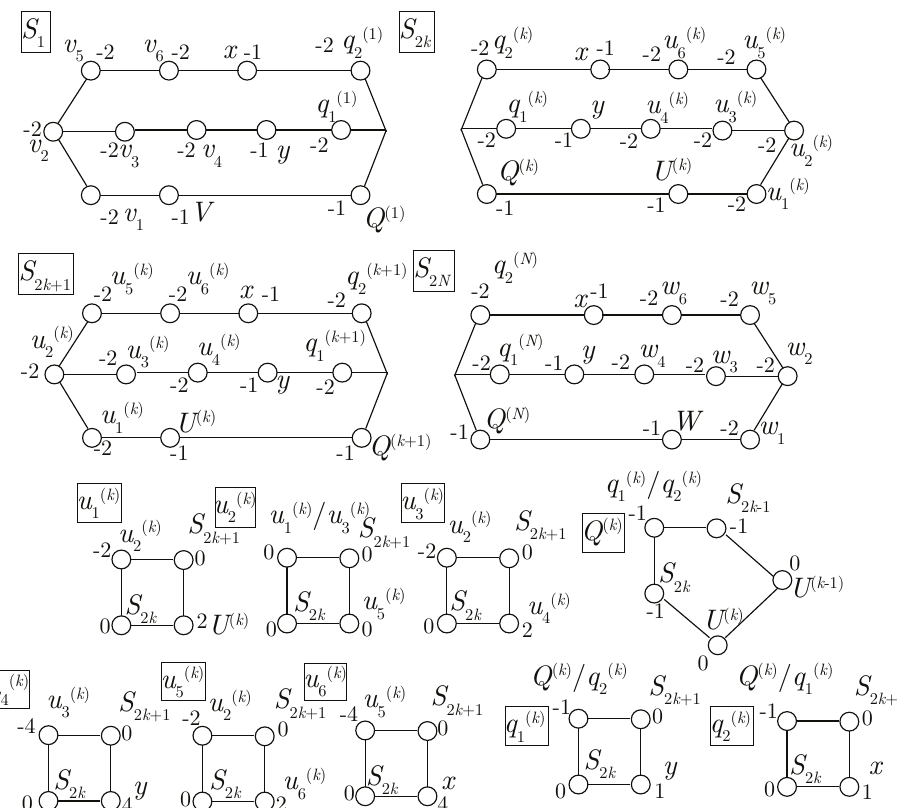
Figure 10. The con(cid:12)guration of curves in the decoupled and (cid:13)opped geometry of (cid:12)gure 9. Note that the decompacti(cid:12)ed surfaces U ( j ) has been